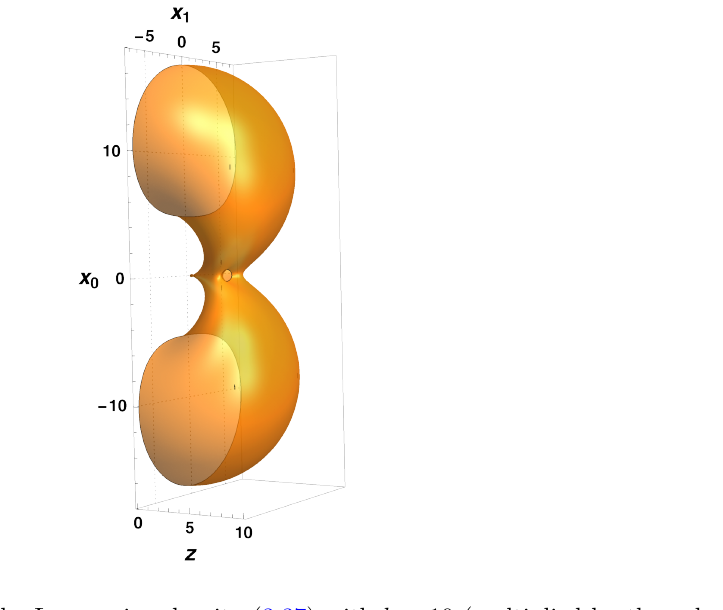
Figure 8 . A 2D contour of the Lagrangian density (3.37) with b = 10 (multiplied by the volume factor 4 πx 3 and assuming x 2 = x 3 = 0 ) evaluated at 10. There are two merons at x 0 = ± 10 , and two antimerons at the origin x 0 = 0 which grow in size as z increases and annihilate at z ∼ 10